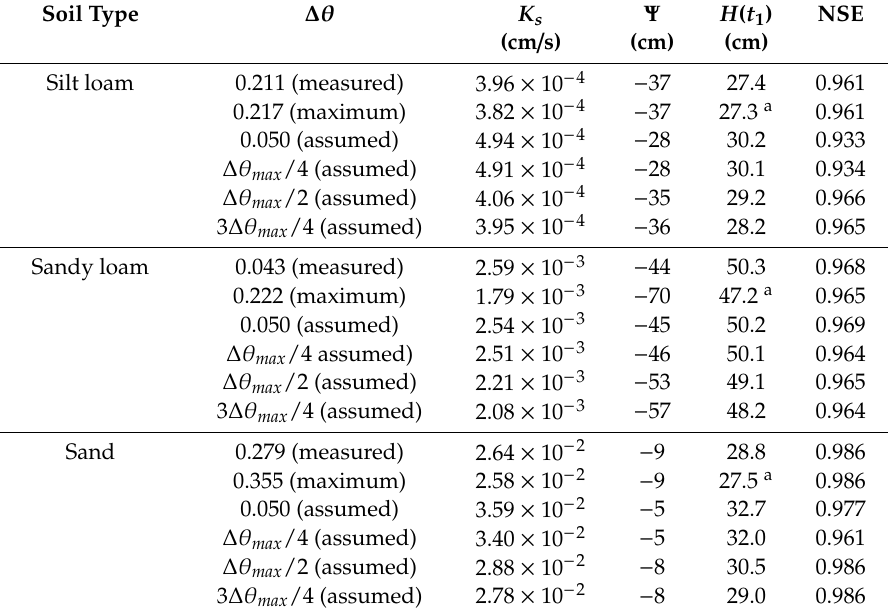
Table 4. Values of the back-fitted saturated hydraulic conductivity K s and the Green–Ampt suction head Ψ at the wetting front for silt loam, sandy loam, and sand using di ff erent moisture deficits ∆ θ